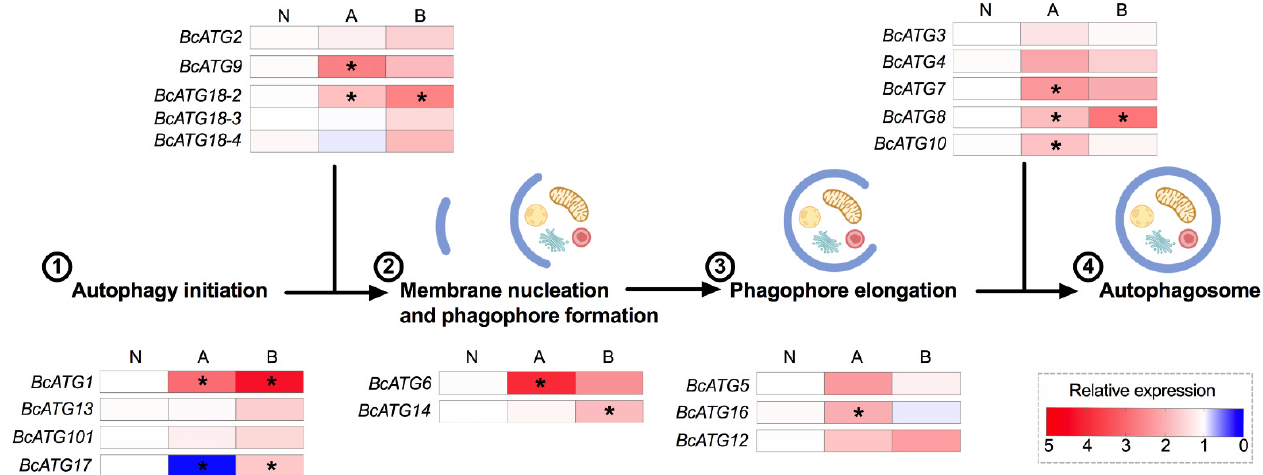
Figure 3. Heat map of gene expression profiles of ATGs in response to LsoA and LsoB persistent infection corresponding to the process of autophagosome formation. N: Lso-free colonies; A and B indicate the psyllids were infected by LsoA and LsoB, respectively. The numbers indicate the steps of autophagosome formation. The asterisks (*) indicate statistical differences compared to control at p < 0.05 using one-way ANOVA with Tukey’s post hoc